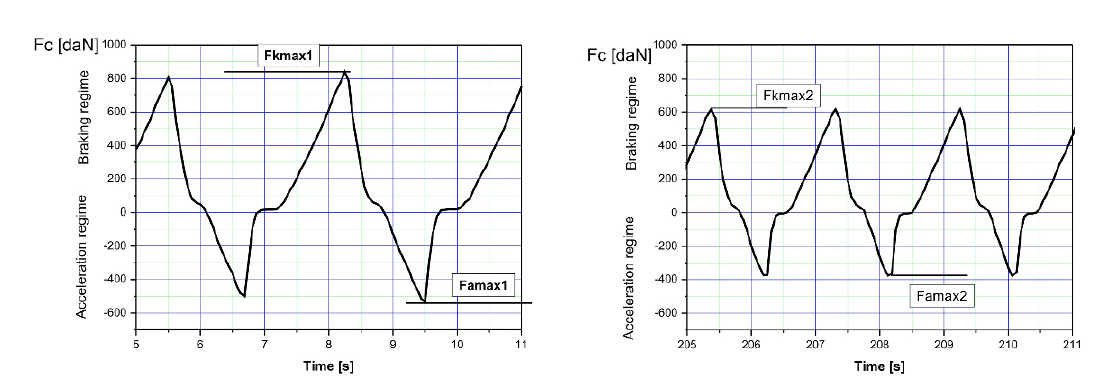
Figure 2. The forces in acceleration-braking, regime 1 (left) and 2 (right).